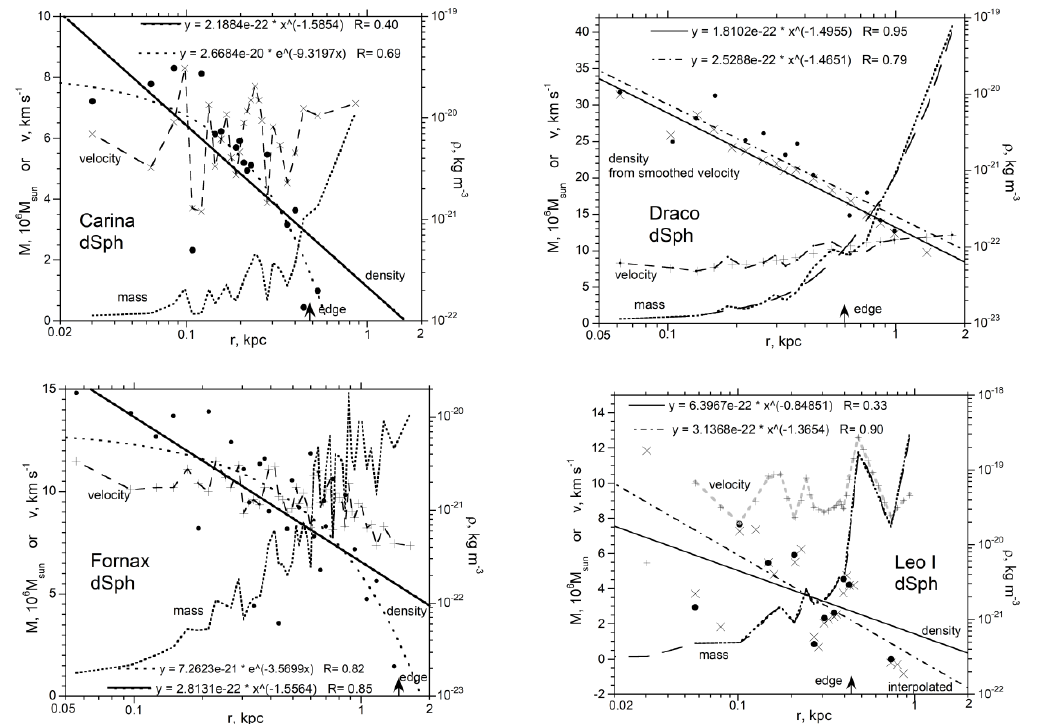
Figure A7. Irregular galaxies: For Holmberg II, squares and dashed line = RCs from Oh et al. [74]. Grey diamonds = RCs from Bureau and Carnigan [85], who state their velocities are not accurate beyond 10 kpc, and so this dataset was not used in the calculations. Dotted line = calculated mass. Circles = calculated density. Two different fits are shown as solid line and widely spaced dotted curve; WLM is unusual due to its isolation RCs from Leaman et al. [73]; M81dWb RCs from Oh et al. [74].